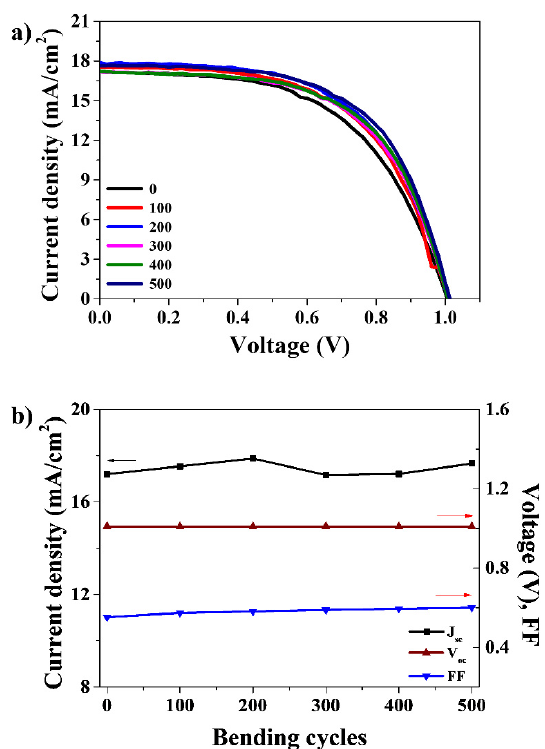
Figure 6. ( a ) Reverse scan current density–voltage (J-V) curves of flexible cells and ( b ) variation in the J SC , V OC , and FF values of flexible cells as a function of bending cycles.